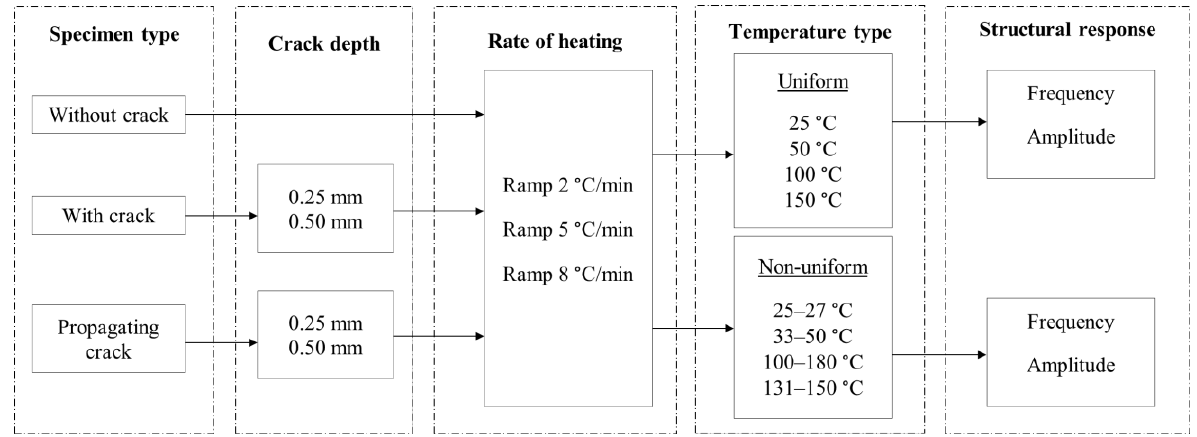
Figure 3. Detail of the experiments.